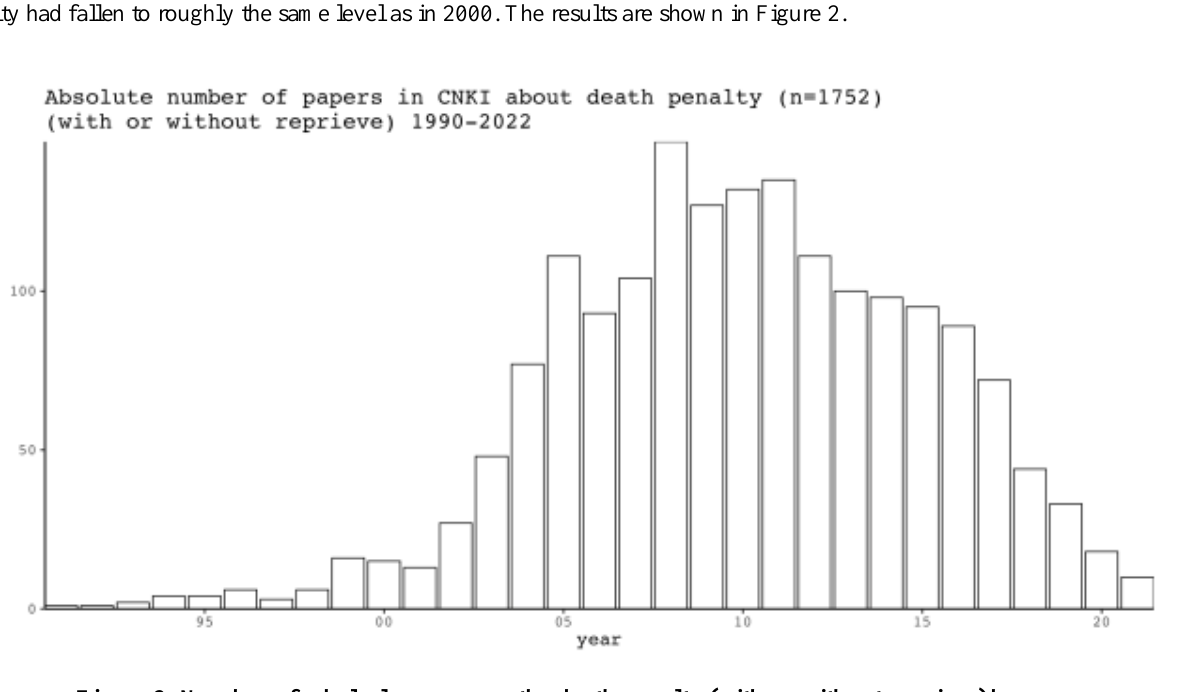
Figure 2: Number of scholarly papers on the death penalty (with or without reprieve) by year. Source: China National Knowledge Infrastructure